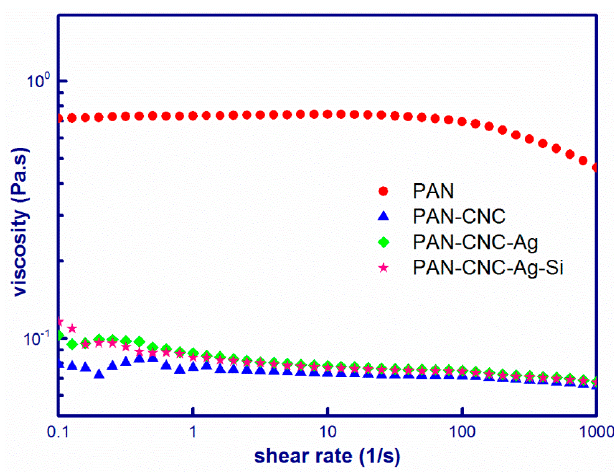
Figure 1. Shear viscosity-shear rate relationships for PAN, PAN/CNC, PAN/CNC/Ag, and PAN/CNC/Ag/Si.